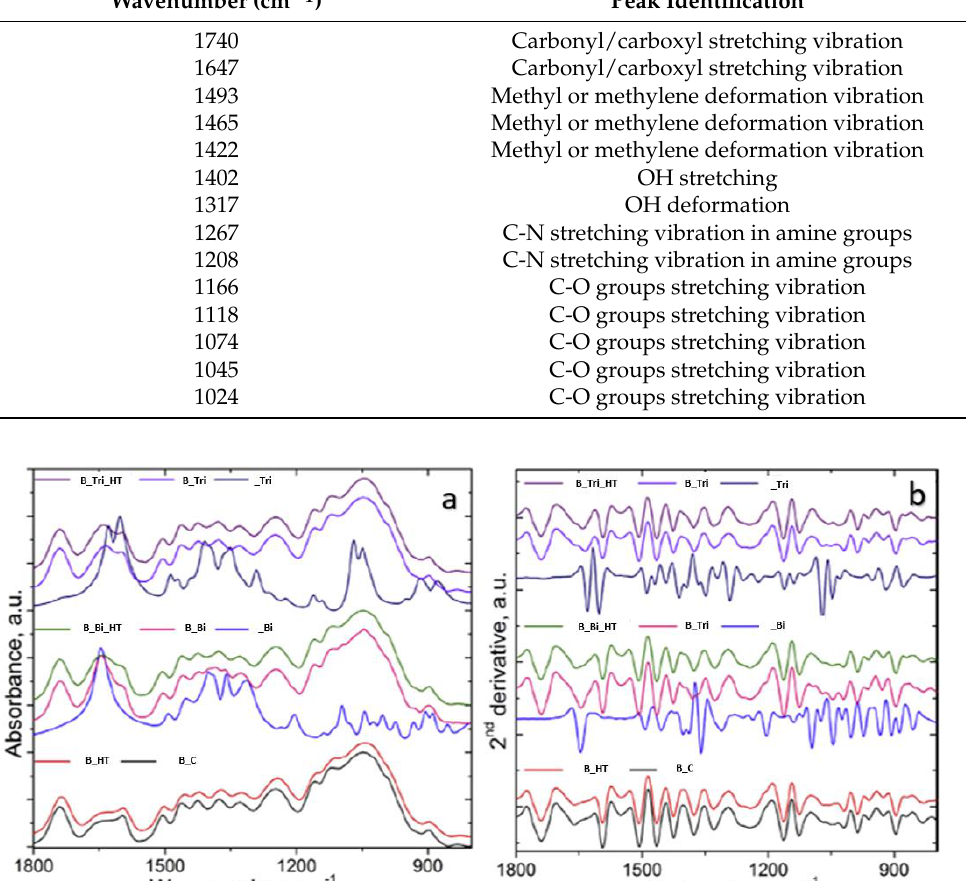
Table 10. Selection of peaks showing significant differences in 2nd derivate FTIR spectra for reactions involving bicine.